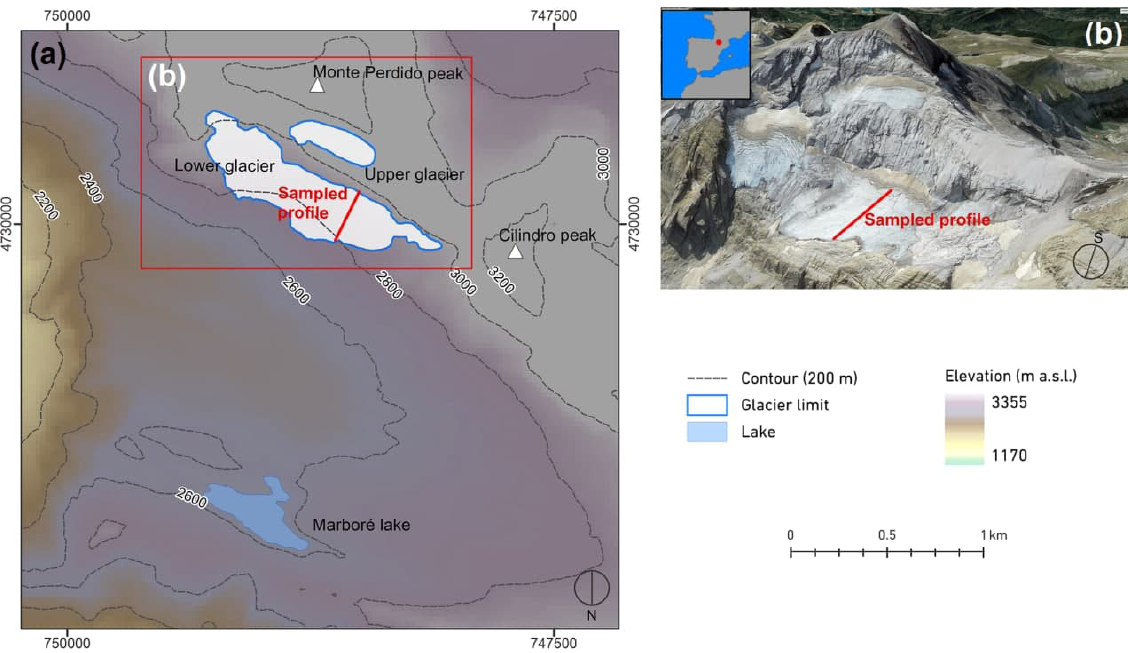
Figure 1. (a) Location of Monte Perdido Glacier (MPG) within a digital elevation map of the Marboré Cirque; (b) picture (© Google Earth) of MPG where the location of the sampled profile is indicated (see Fig. 2).